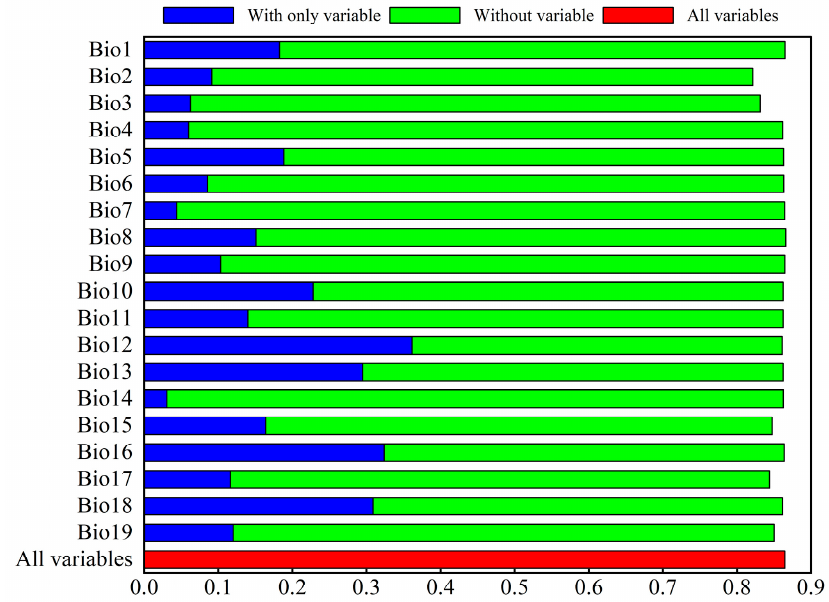
Figure 3. Jackknife test for climatic factors in the current potential distribution model of Carex alatauensis . Table 2. Contribution rate of each climatic factor for the distribution of Carex alatauensis.